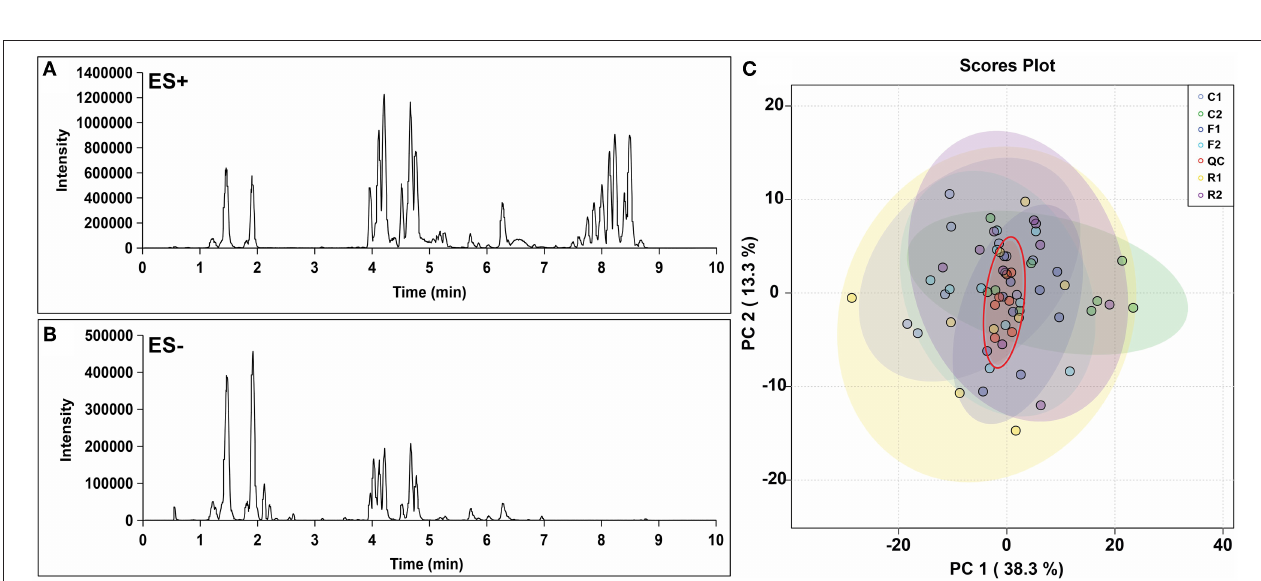
FIGURE 4 | Chromatogram and PCA score plot of lipidomics data. (A) Lipidomic chromatogram at positive ion mode (ES + ). (B) Lipidomic chromatogram at negative ion mode (ES-). (C) PCA score plot from the lipidomics data for all samples, including quality control (QC). n = 9-10. (R1 have 9 rats, C1, F1, C2, R2, and F2 have 10 rats). “n” means the number of samples/rats per